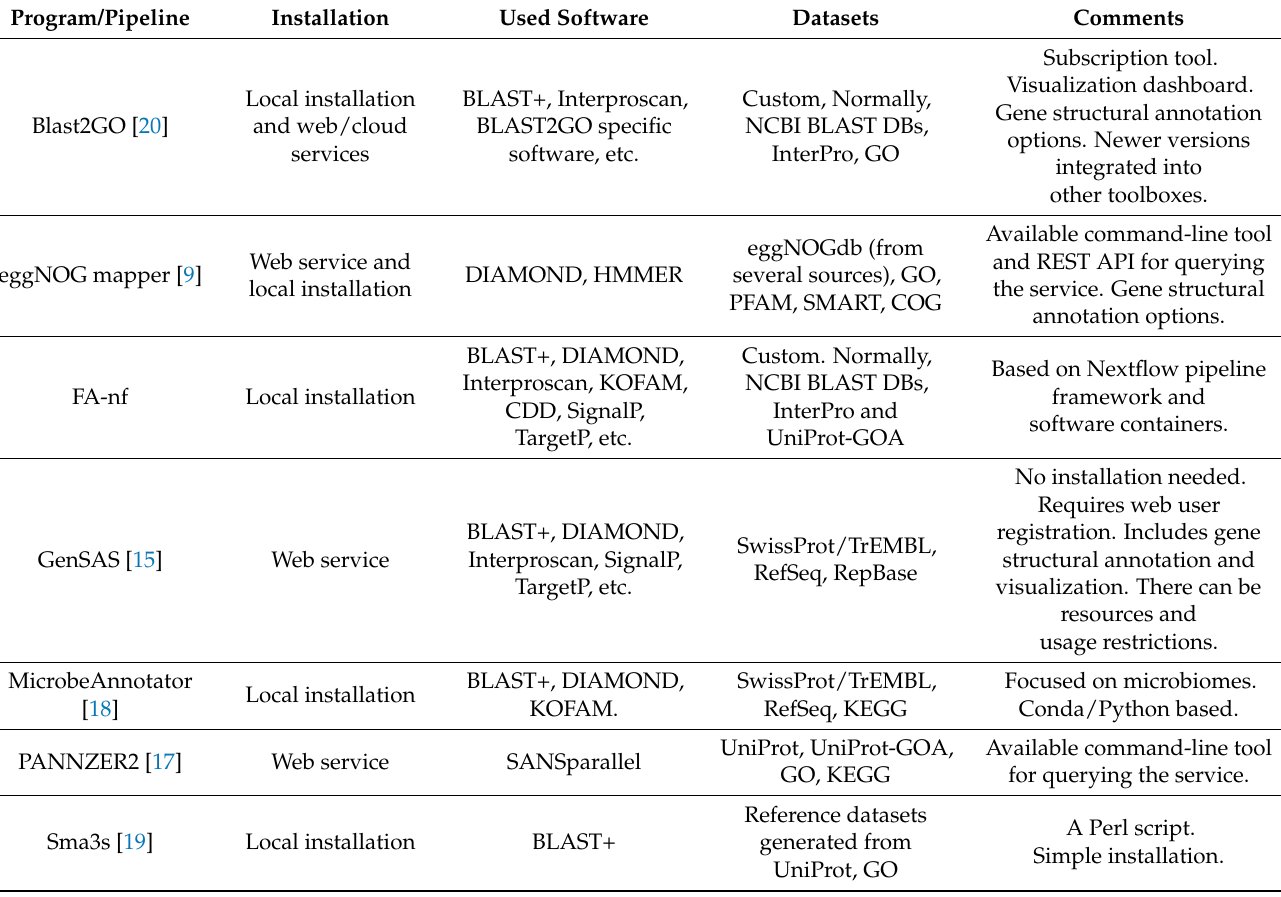
Table 1. Non-exhaustive summary table of existing functional annotation programs or